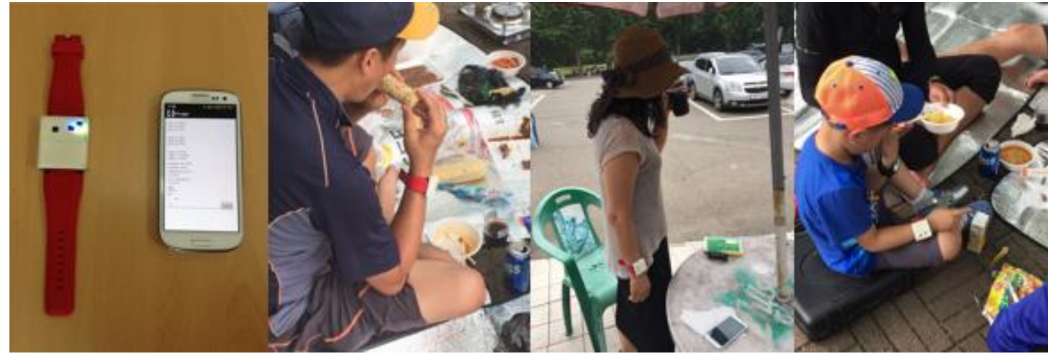
Figure 2. Smartphone and wrist-wearable device for data